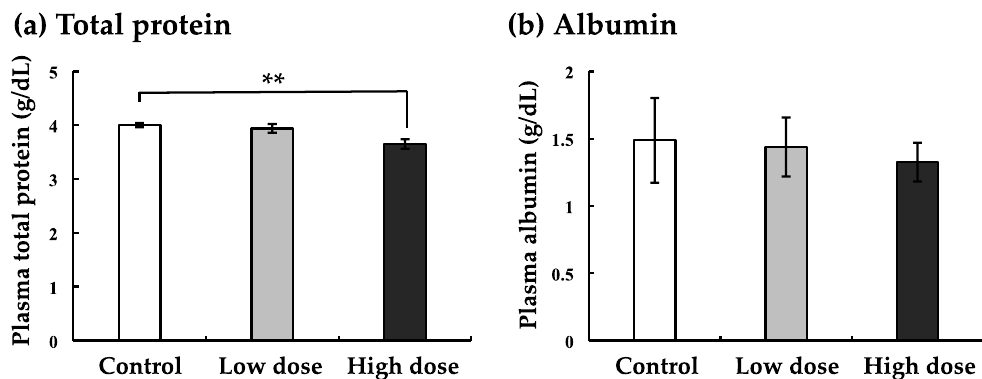
Figure 2. Effects of BaA on osteoclastic (a) and osteoblastic (b) marker messengerRNA (mRNA) expression in the scales of BaA-treated or untreated nibbler fish. BaA (10 ng/g body weight) was injected intraperitoneally (four times) into nibbler fish for 10 days during breeding. Thereafter, osteoclastic and osteoblastic marker mRNA expressions were examined in the control and experimental groups. * indicates a statistically significant difference at p < 0.05 from the values in the control scales (n = 8).